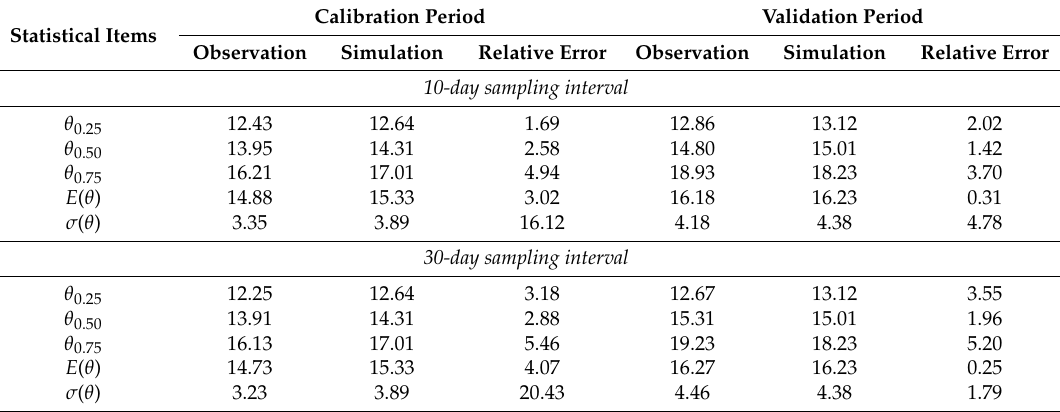
Table 9. Statistical characteristics of soil moisture θ at different sampling intervals (Unit: %).